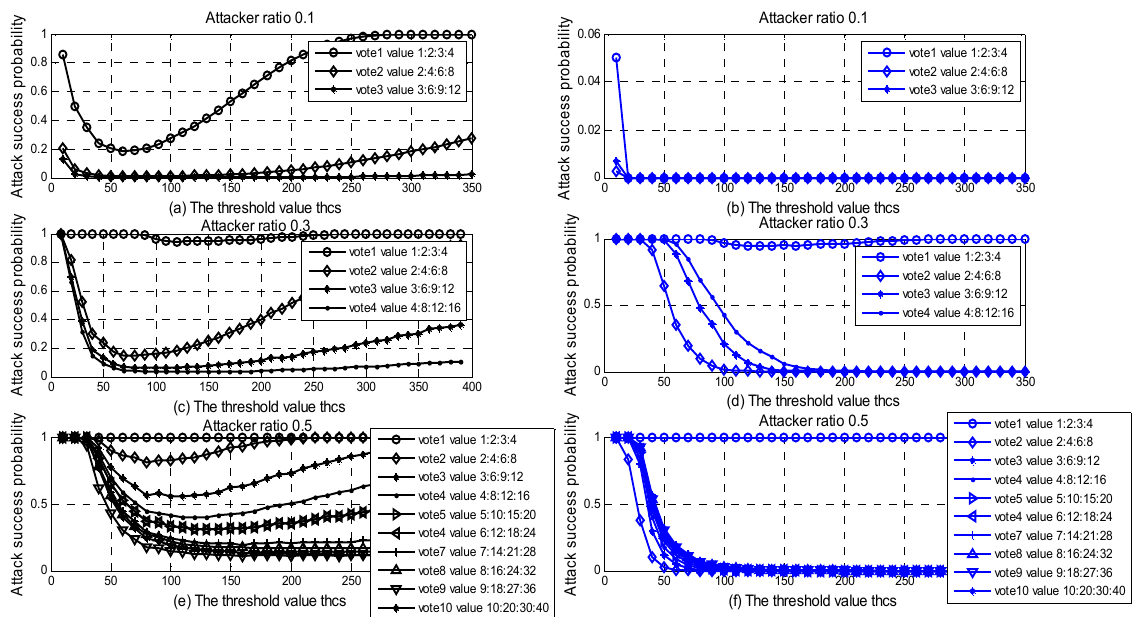
Figure 8. The change curve of the attack probability with increase in VW. Panels ( a – f ) analyze the change curve of the successful attack probability in Formulas (13) and (15) when the vote weight VW 1 , VW 2 , VW 3 , and VW 4 increases from 1, 2, 3, and 4 to 10, 20, 30, and 40 and the conspirator ratio is 0.1, 0.3, and 0.5 with 100 users.